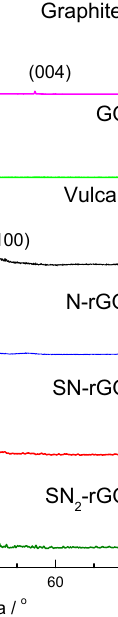
Table 2. Elemental analysis for all studied materials.